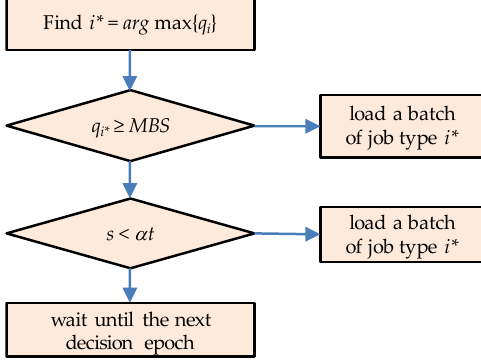
Figure 5. Decision procedure of look-downstream rule (LKDN).